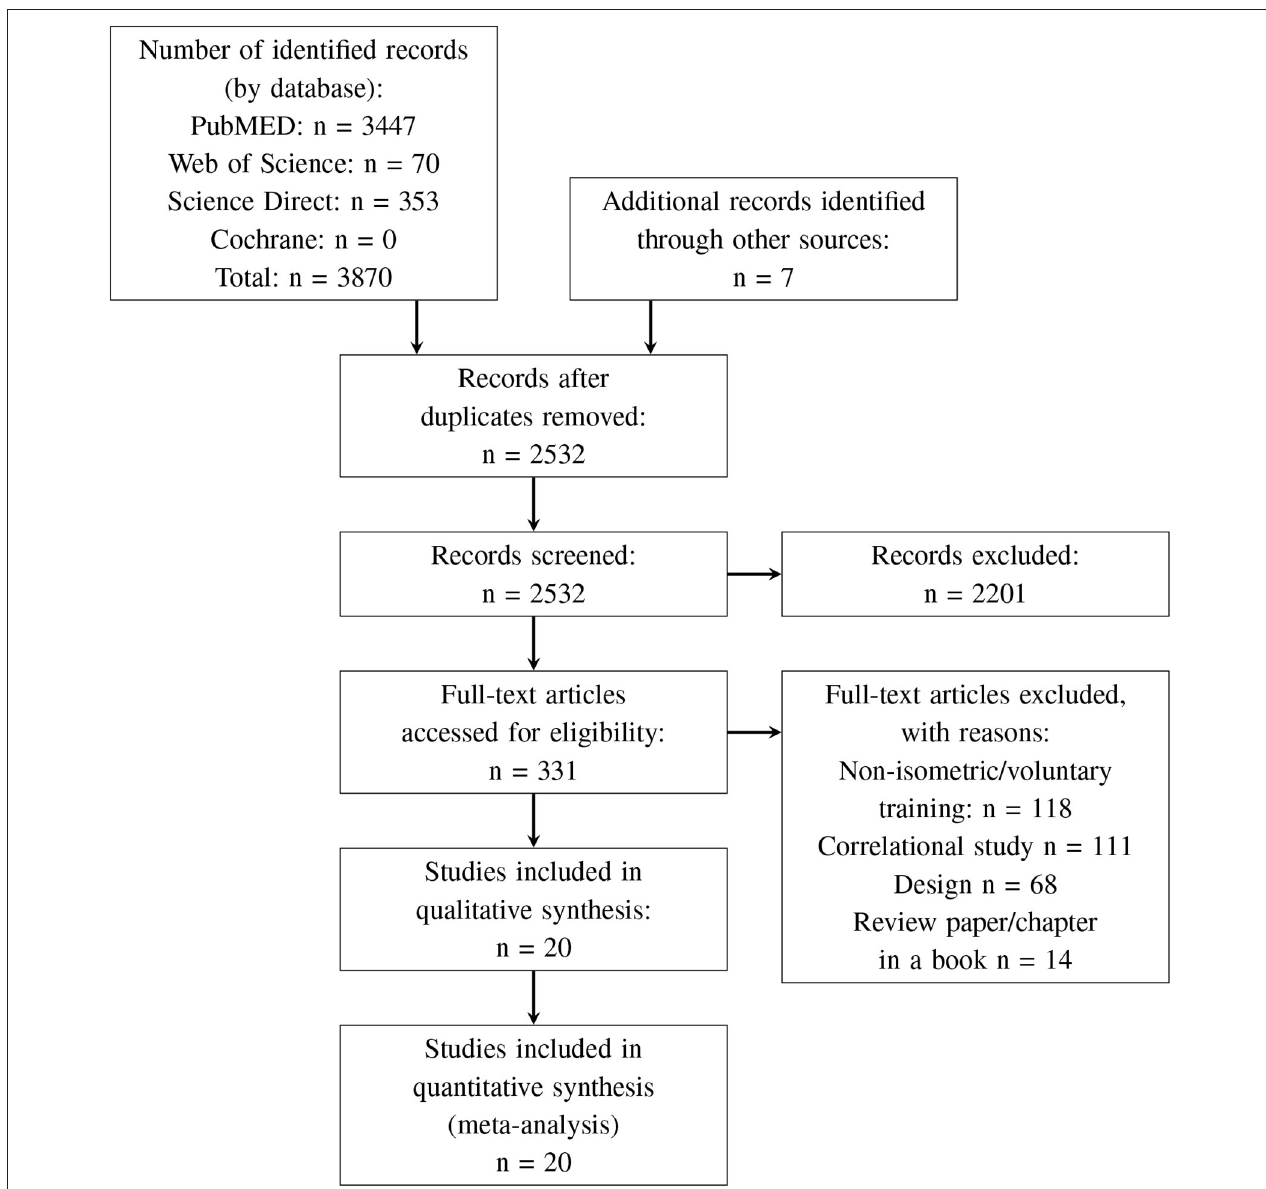
FIGURE 3 | PRISMA 2009 flow